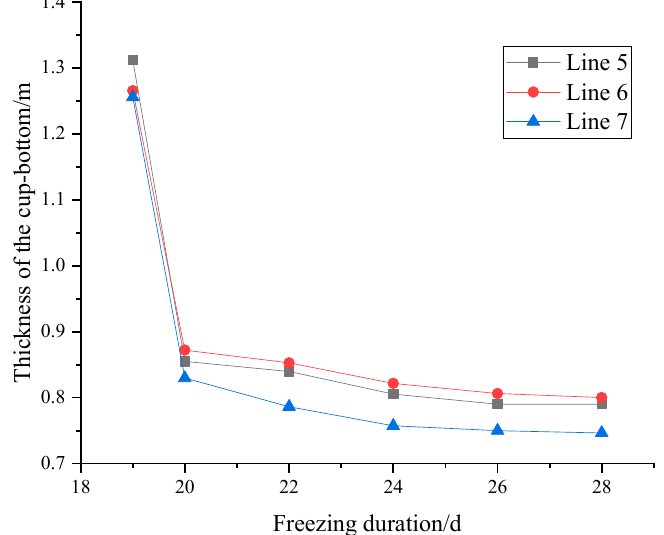
Figure 14. Thickness of the frozen curtain in different line.